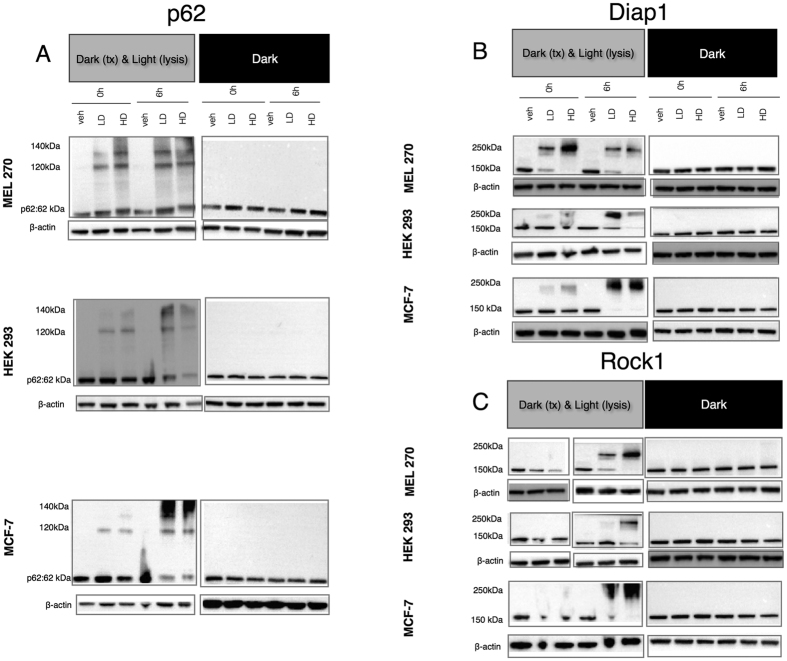
Light is needed for the formation of p62 (1A) Diap1 (1B) and Rock1(1C) oligomers in MEL 270, HEK-293 and MCF-7 cell lines.Western-blot of protein extracts from cells treated with vehicle (veh.), low dose (LD, 1.25 μg/ml) or high dose (HD, 7.5 μg/ml) Verteporfin (VP) for 0 and 6 hours. Verteporfin treatment of cells was always performed in darkness. Right column demonstrates experiments performed in absolute darkness during all steps (treatment, lysis and electrophoresis). Left column demonstrates experiments performed without shielding from light subsequent to cell lysis. (i.e. cell lysis and electrophoresis performed in ambient light). When all steps were performed in absolute darkness no high molecular weight cross-linked oligomers were observed. Ambient light after cell lysis led to VP inducing cross-linked oligomers.